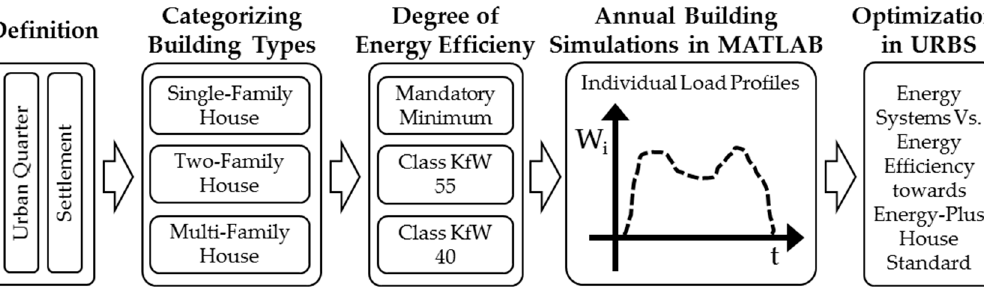
Figure 1. Methodology with exemplary sub items.